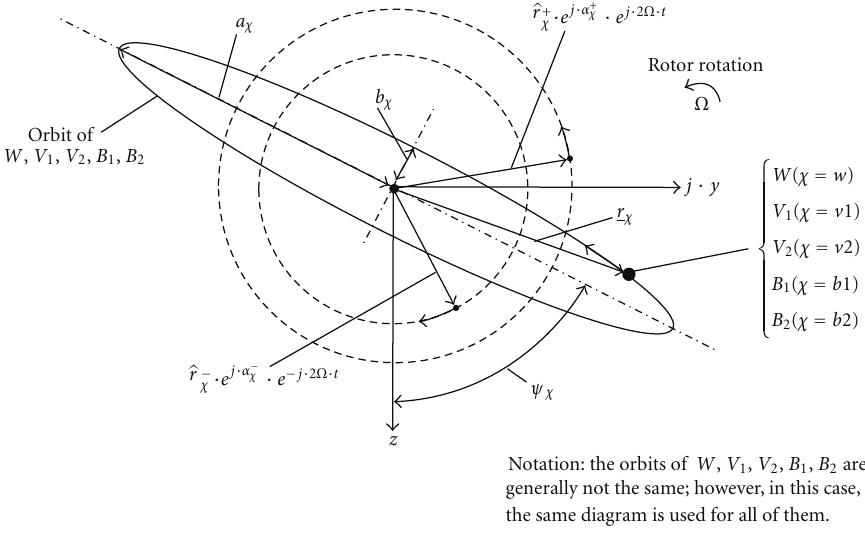
Figure 6: Absolute orbits of the points W , V 1 , V 2 , B 1 , B 2 , described by ellipse parameters a χ , b χ , and Ψ χ .